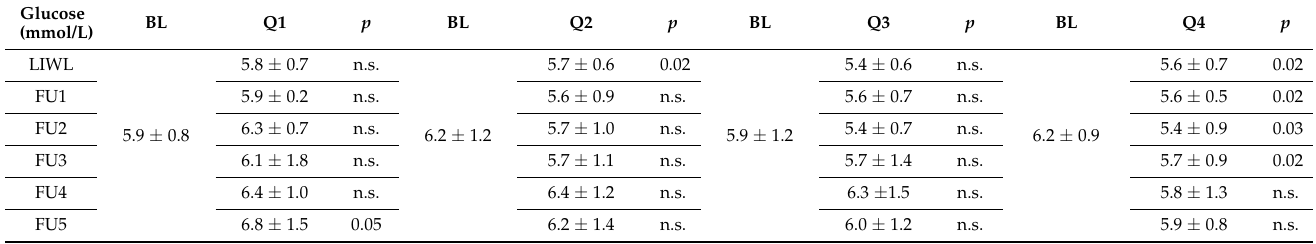
Table 6. Median and interquartile ranges of fasting plasma glucose levels before and after LIWL and during the 5-year